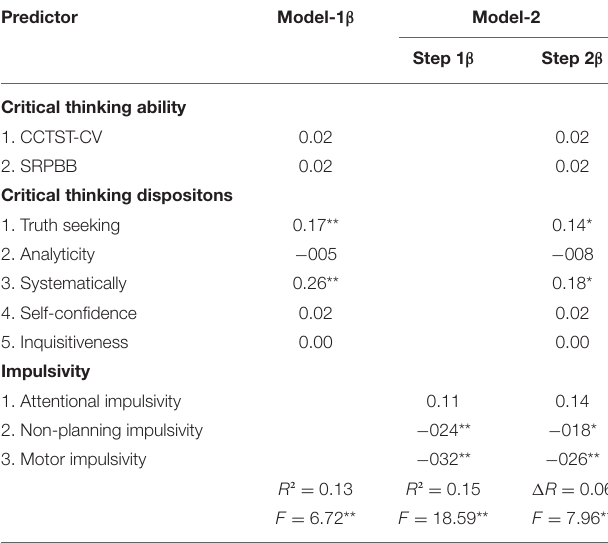
TABLE 2 | Hierarchical regression models predicting mental health from critical thinking skills, critical thinking dispositions, and impulsivity ( N =